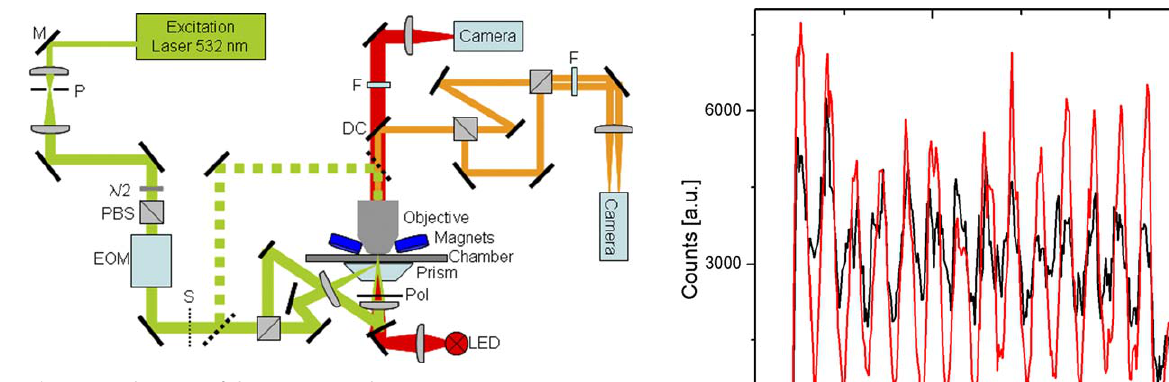
Figure 4. Schematic of the Experimental Setup Combined SMFP and magnetic tweezers setup. M, mirror; P, pinhole; k /2, k /2 plate; PBS, polarizing beam splitter; EOM, electro optical modulator; S, shutter; F, filter; Pol, polarizer; DC, dichroic mirror. Dashed components can be removed and are solely used for alignment purpose.